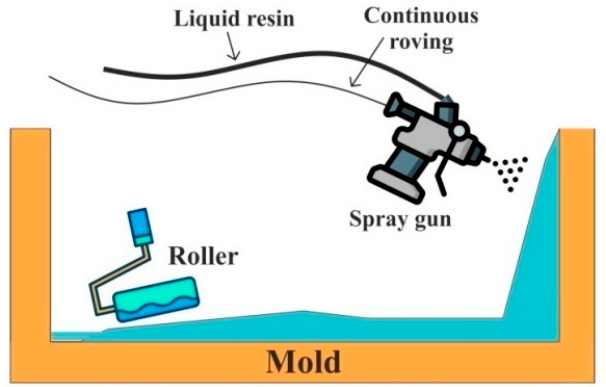
Figure 4. Spray-up process.